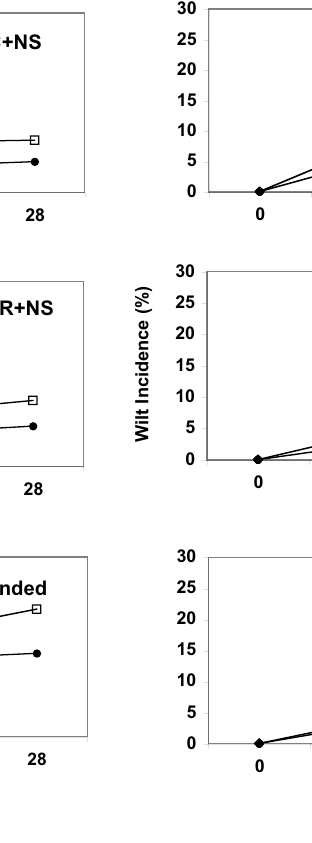
Fig . 1. Dry root rot of clusterbean in soils amended with mustard oil-cake (MC), mustard residue (MR), and with summer irrigation (SI), or without summer irrigation (NS, normal sowing). LSD ( P =0.05): treatment 1.3; in- terval 0.8; treatment (cid:1) interval 2.6.